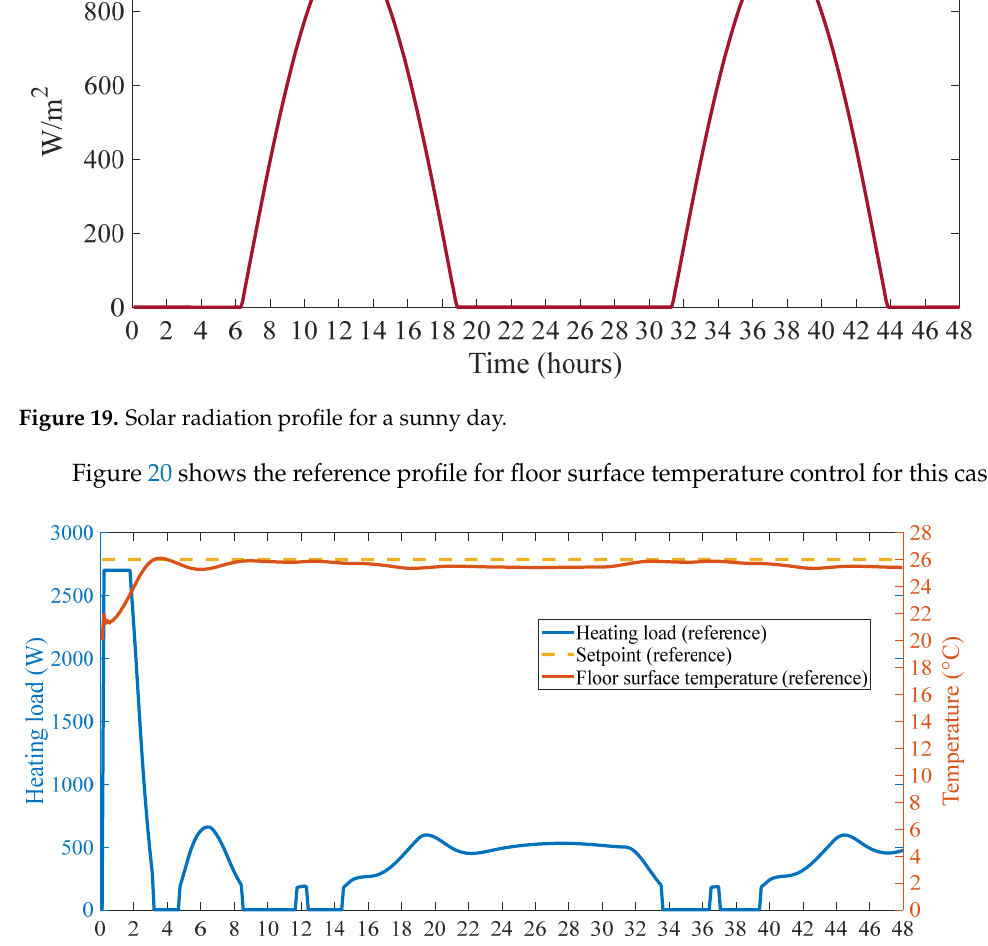
Figure 20. Reference case for floor surface temperature control with solar radiation.